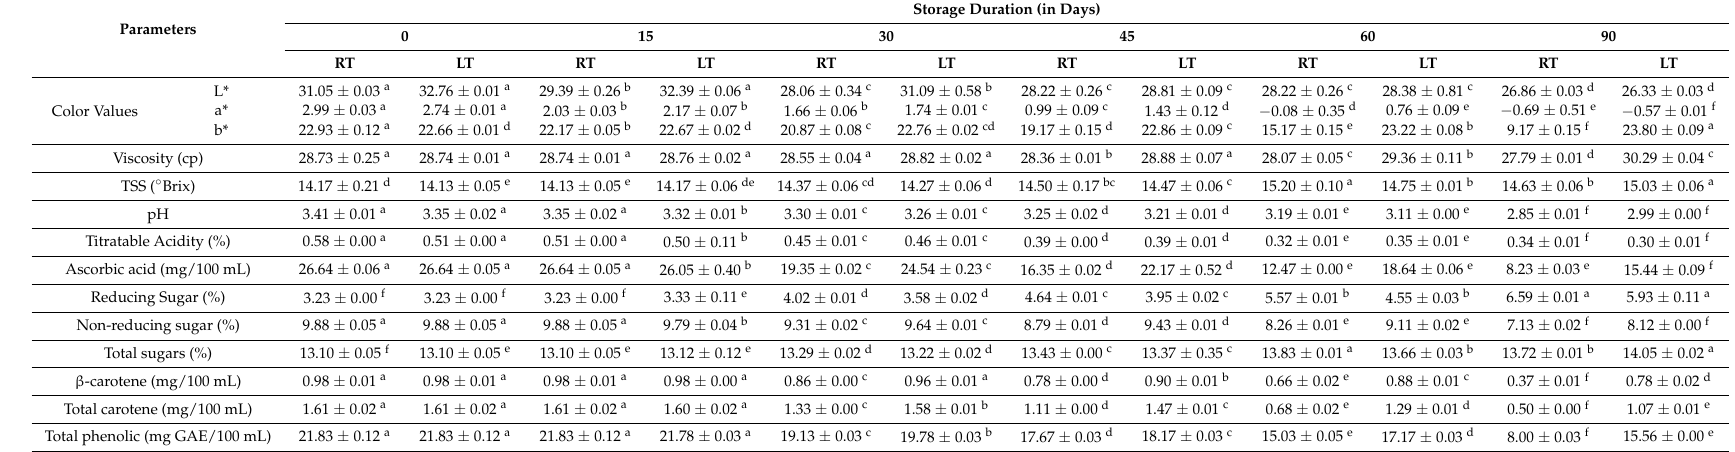
Note: ( n = 3; average ± SD), values in rows with different superscripts (a–f) have significant differences at p < 0.05 by DMRT Test. L* indicates luminosity, a* corresponds to greenness ( − )/redness (+), and b* corresponds to blueness ( − )/yellowness